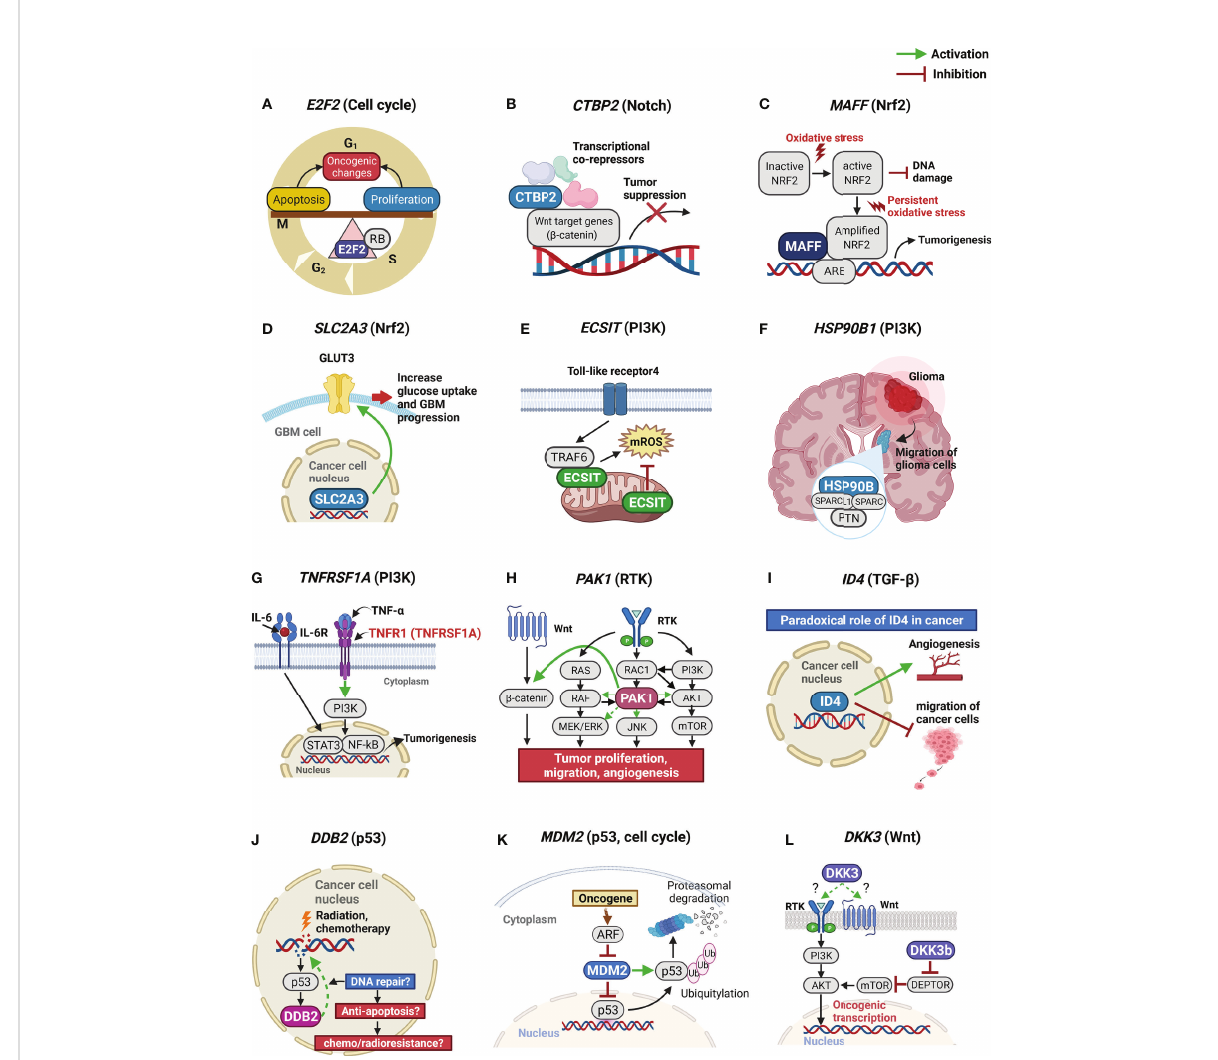
FIGURE 2 Schematic illustrations of possible roles of the 12 signi fi cant genes in GBM. GBM, glioblastoma. (A) E2F2 is the center of the balance between cell proliferation and cell cycle arrest or apoptosis; (B) CTBP2 is a nuclear transcriptional co-repressor. CTBP2 represses Wnt target genes leading to tumor suppression; (C) Higher expression of MAFF promotes its binding to Nrf2. When stress conditions persist, MAFF and the Nrf2 complex activate ARE, leading to tumorigenesis; (D) SLC2A3 encodes the GLUT3. Because of excessively high glucose consumption of tumor cells, aberrant GLUT3 expression is known to associate with poor prognosis in brain tumors; (E) A TRAF6-ECSIT complex is crucial for the generation of mROS. ECSIT also regulates the production of mROS; (F) Protein complex, containing PTN, SPARC, SPARCL1, and HSP90B, facilitates the migration of glioma cells; (G) TNFRSF1A encodes the TNF a receptor. TNF a and IL6 induce sustained NF- k B activity, aberrant activation of STAT3, and increased expression of pro-oncogenic proteins; (H) PAK1 functions as a node for multiple signaling pathways. PAK1 overexpression is associated with activation of PI3K/AKT/mTOR and facilitates cross-talk between the Ras effector pathways and the Wnt signaling pathway associated with tumor progression, migration, and angiogenesis; (I) ID4 can act as a tumor suppressor and an oncogene in different tumor types. ID4 may act as a migration suppressor of GBM. At the same time, however, ID4 also promotes angiogenesis in GBM. (J) DDB2 plays a critical role in DNA repair system. However, in cancer cell, DDB2 may also promotes repair of cancer DNA lesions induced by radiation or chemotherapy, leading to chemo/radioresistance. (K) MDM2 is the primary negative regulatory factor of the p53 protein; (L) DKK3 may modulate cancer cell malignant potentials by activating AKT thorough the binding of DKK3 to RTK or Wnt receptors and by intracellular protein-protein interactions of DKK3b. GBM, glioblastoma multiforme; E2F2, E2F transcription factor 2; CTBP2, C-terminal-binding protein 2; MAFF, MAF bZIP transcription factor F; Nrf2, nuclear factor erythroid 2-related factor 2; ARE, antioxidant response element; SLC2A3, solute carrier family 2 member 3; GLUT3, glucose transporter, type 3; TRAF6, tumor necrosis factor receptor associated factor 6; ECSIT, evolutionarily conserved signaling intermediate in Toll pathways; mROS, mitochondrial reactive oxygen species; PTN, pleiotrophin; SPARC, secreted protein acidic and cysteine rich; SPARCL1, SPARC like 1; HSP90B1, heat shock protein 90 kDa beta member 1; TNFRSF1A, tumor necrosis factor receptor superfamily member 1A; TNF, tumor necrosis factor; IL, interleukin; NF- k B, nuclear factor-kappa B; STAT3, signal transducer